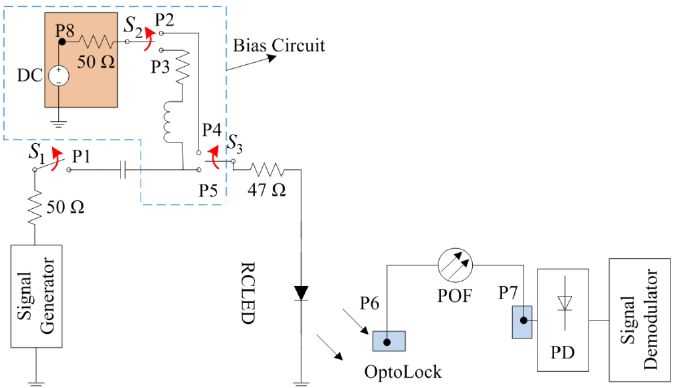
Figure 1. Polymer optical fiber (POF) system with resonant cavity light emitting diode (RCLED).